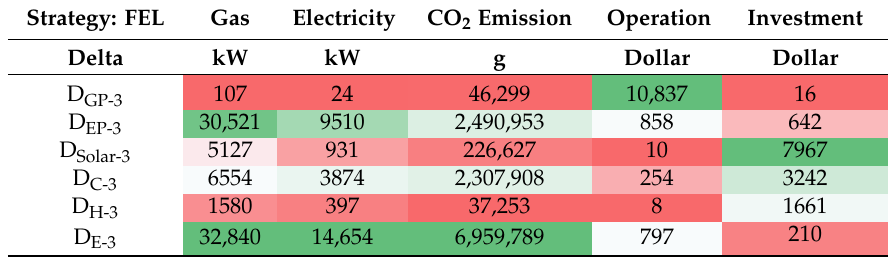
Table 11. The absolute deviation of optimal operation and cost between the single uncertain cases and case